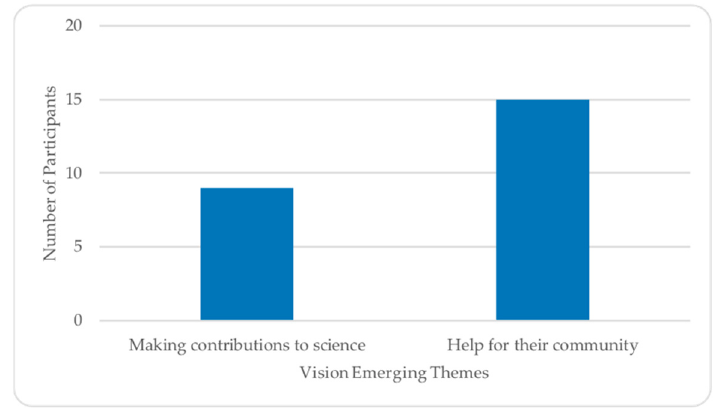
Figure 7. The frequency of emerging themes for the code vision.